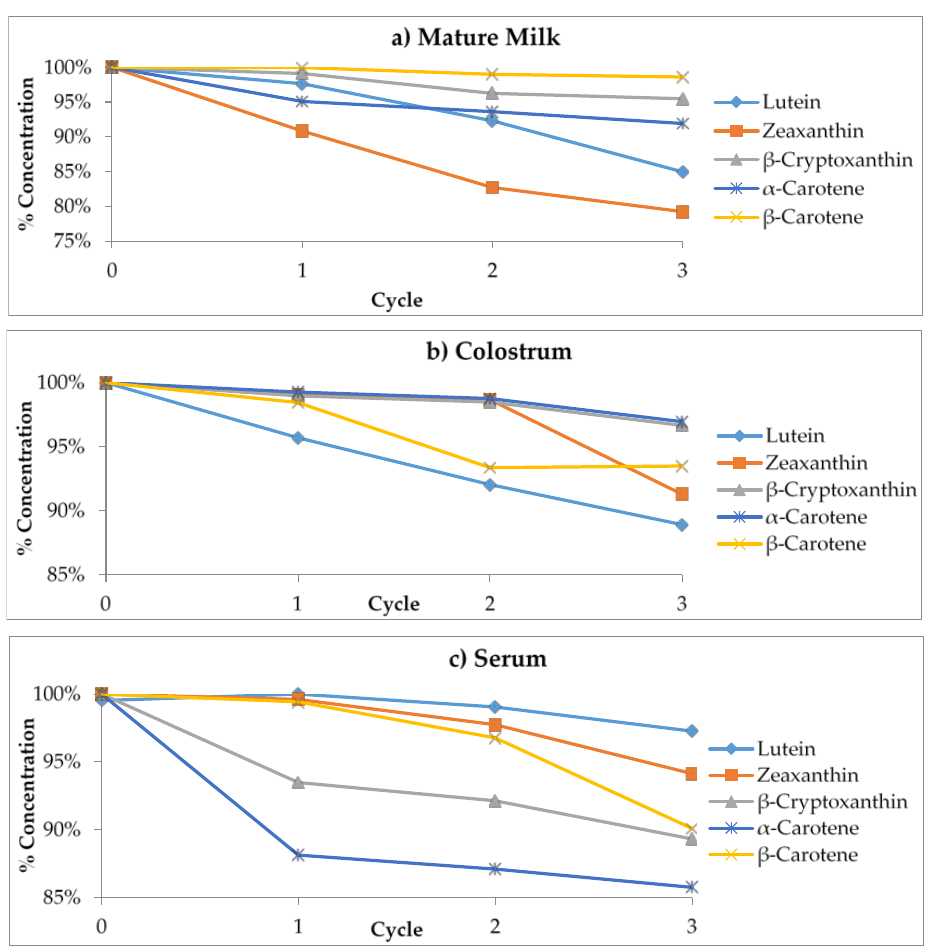
Figure 4. Effect of freeze/thaw on carotenoids in ( a ) mature milk; ( b ) colostrum; and ( c ) serum samples stored at − 70 °C. Y axis: Concentrations of carotenoids (normalized to percentage). X axis: Freeze/thaw cycles.